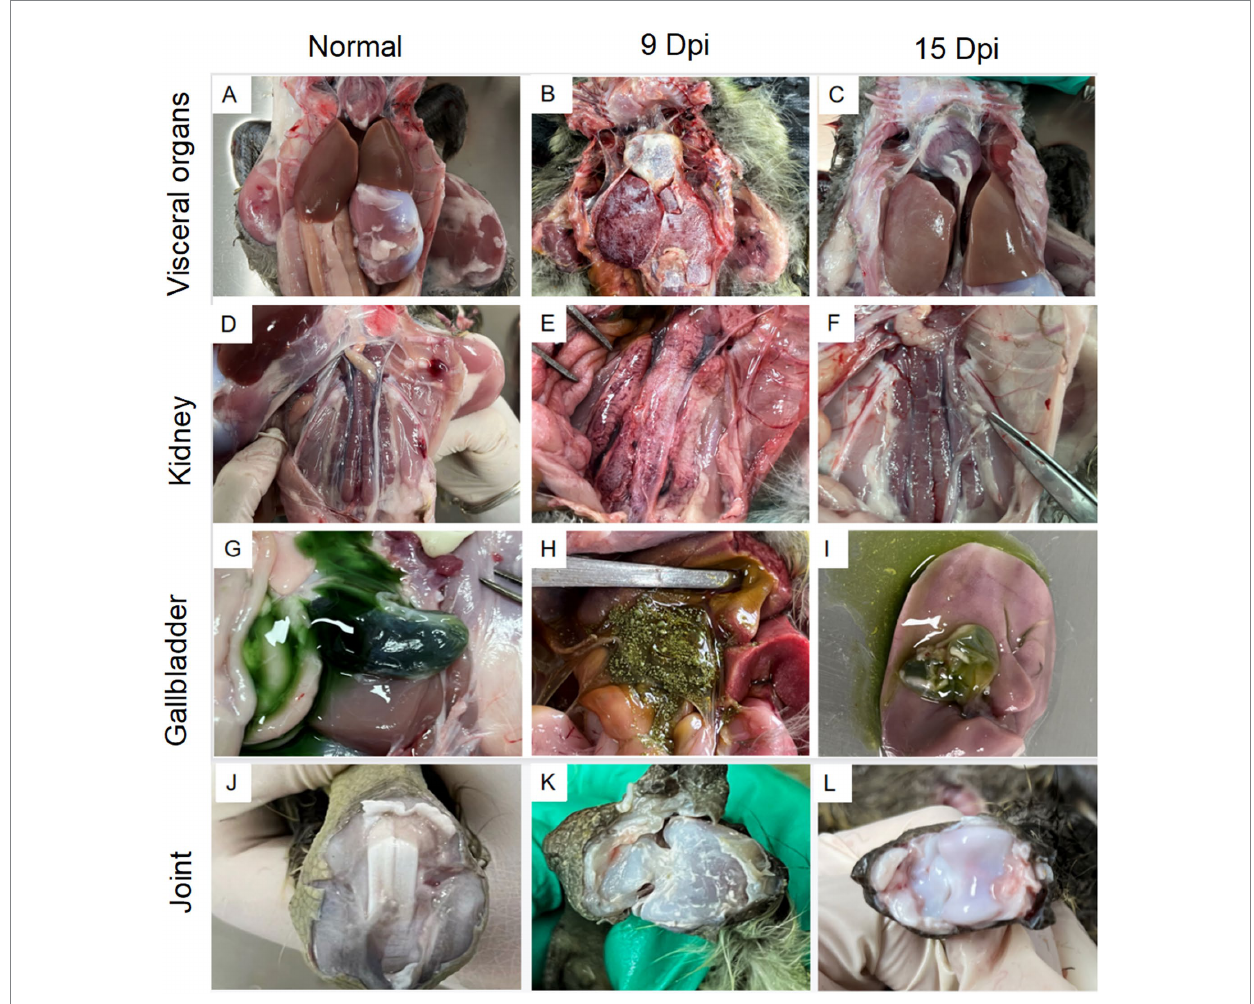
FIGURE 6 Gross lesions in lethal and non-lethal goslings infected with the GoAstV-GD2101 isolate. (A,D,G,J) Control group. (B,E,H,K) Urate deposits in the liver, kidneys, gallbladder, and joints after 9 dpi. (C,F,I,L) Urate deposits in the liver, kidneys, gallbladder, and joints after 15